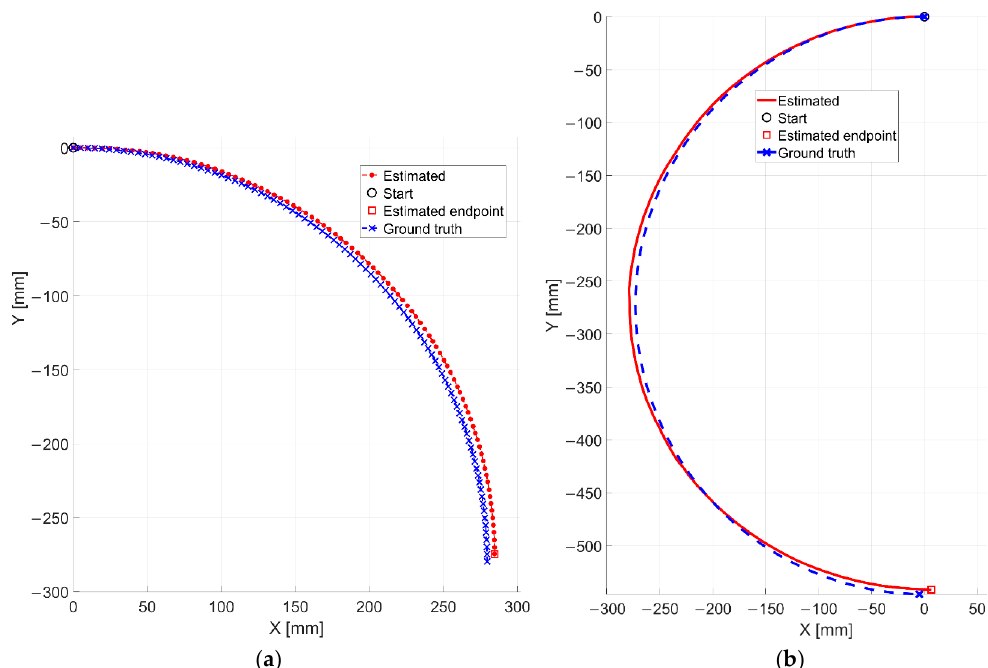
Figure 18. Estimated trajectories related to the ( a ) experiment VII and ( b ) the experiment VIII compared with the reference ones.